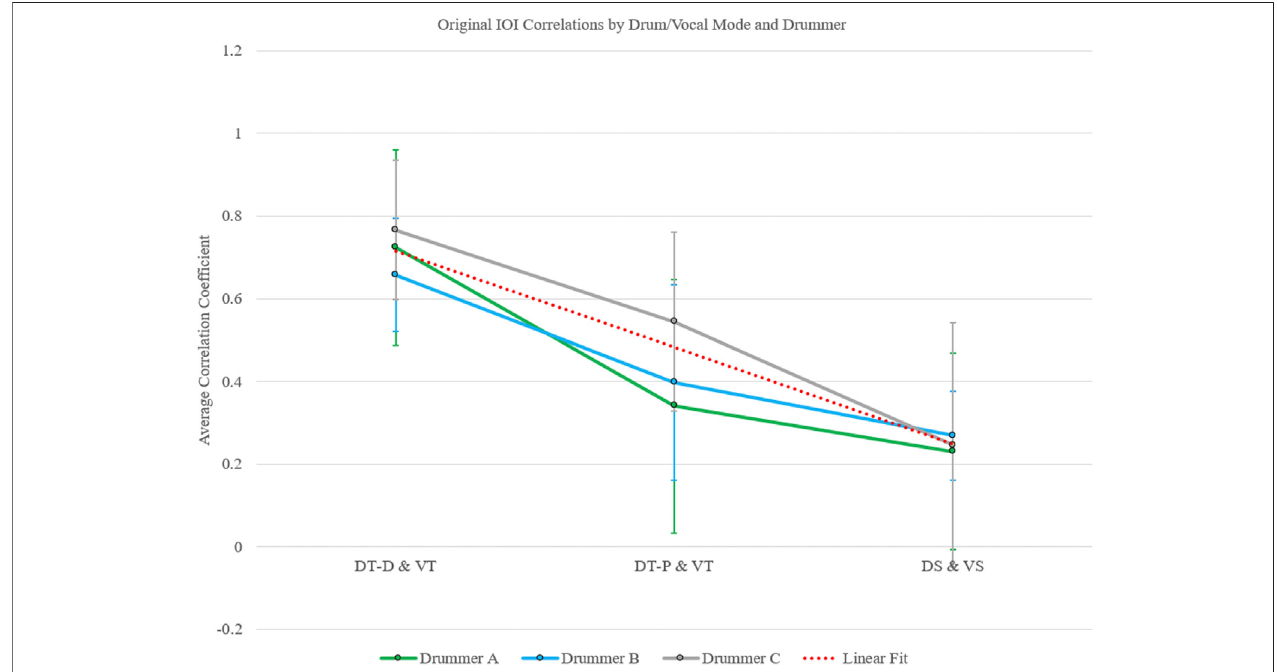
FIGURE 6 | Original IOI correlations between modes and drummers. The data closely follows the linear fi t (dotted red line), showing a successive, incremental decrease in average correlation coef fi cient as the drum/vocal gains musical rhythms. As discussed later, this is likely due to the presence of increasing inter-phrase rhythms as modes become more musical. Error bars are ± 2